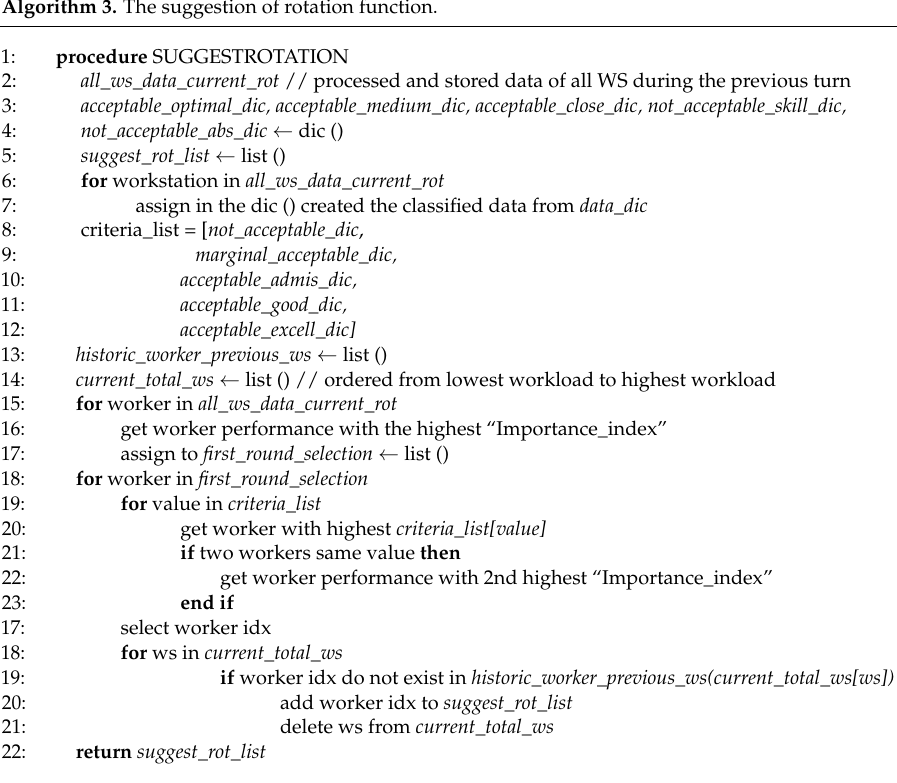
Algorithm 3. The suggestion of rotation